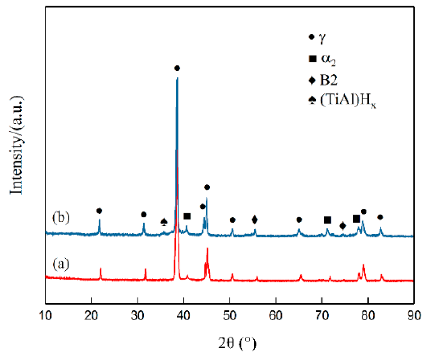
Figure 3. XRD patterns of the unhydrogenated ( a ) and hydrogenated ( b ) Ti–45Al–9Nb alloys.